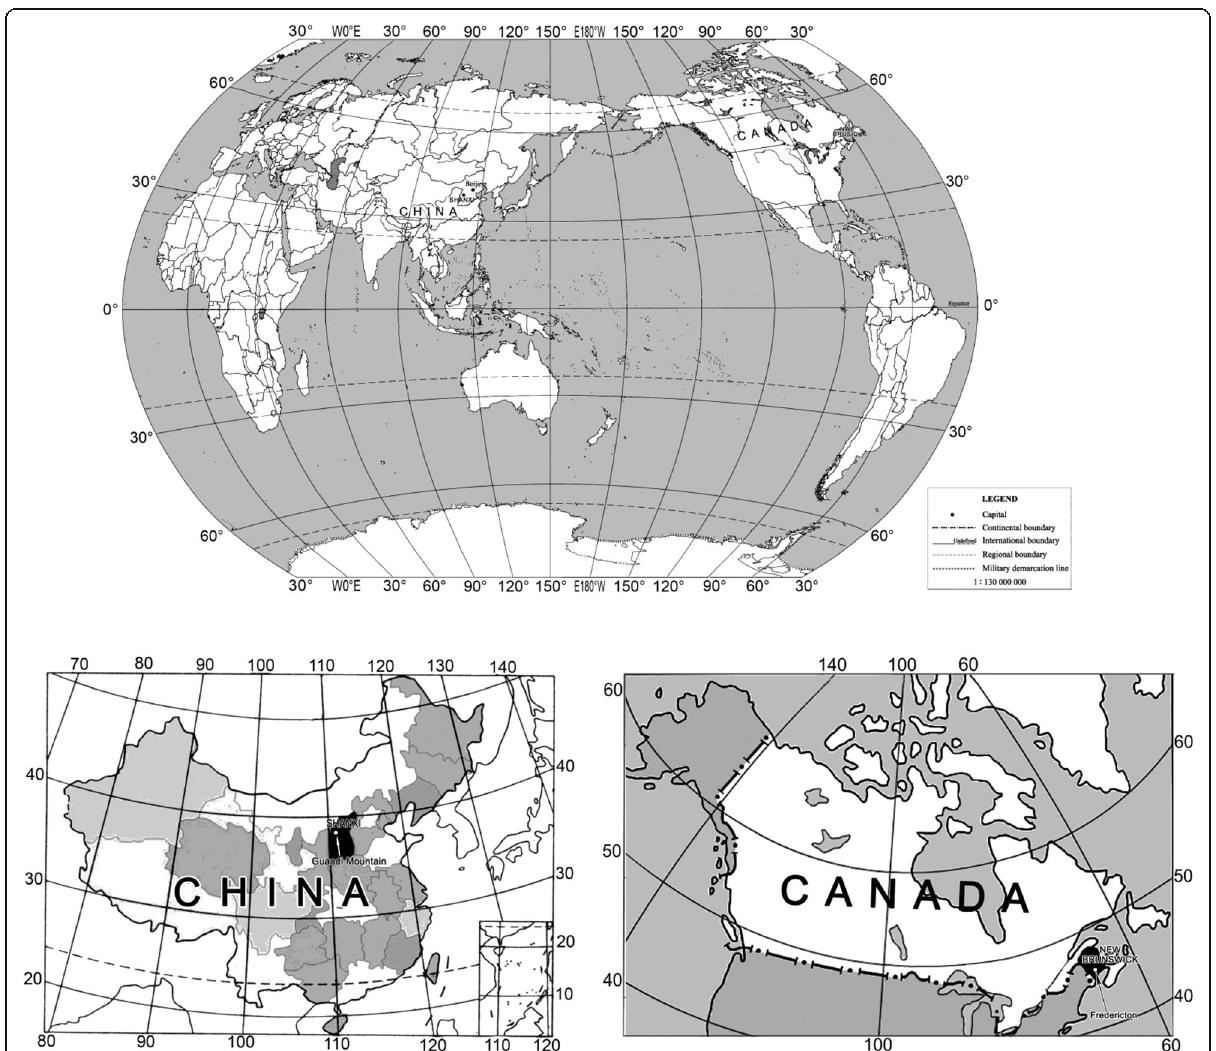
Fig. 1 Geographical maps of the world, Canada and China, showing geographical range and sites of species and seed